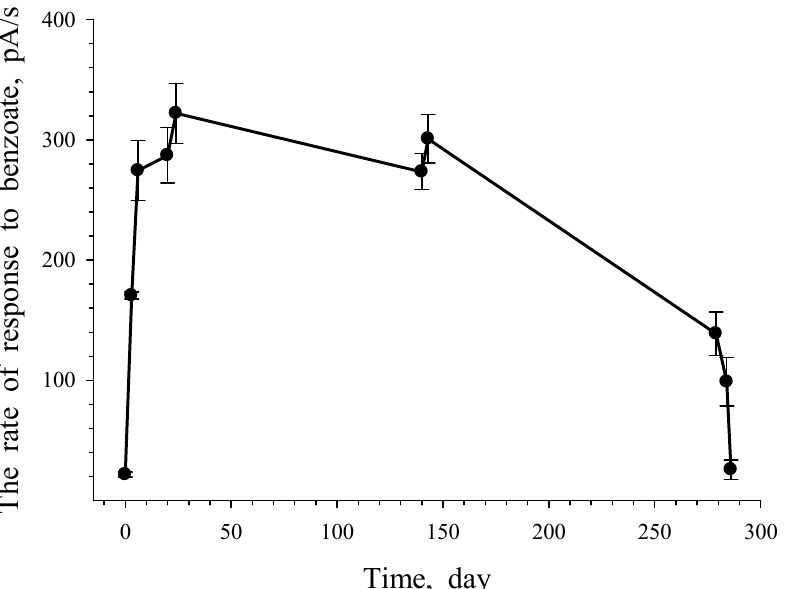
Figure 12. Response of G. polyisoprenivorance 135 immobilized cells toward benzoate. Each dot reflects the rate of oxygen consumption with the injection of benzoate.